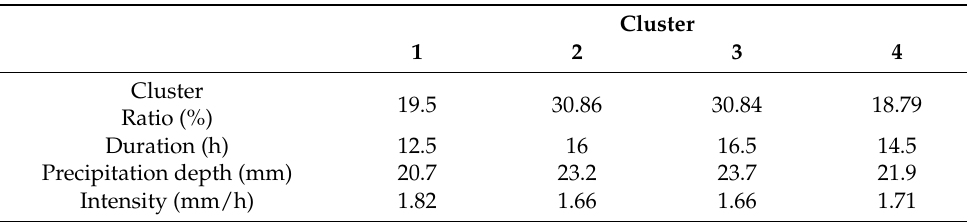
Table 2. Average values of occurrence of clusters, duration and precipitation depth intensity of clusters’